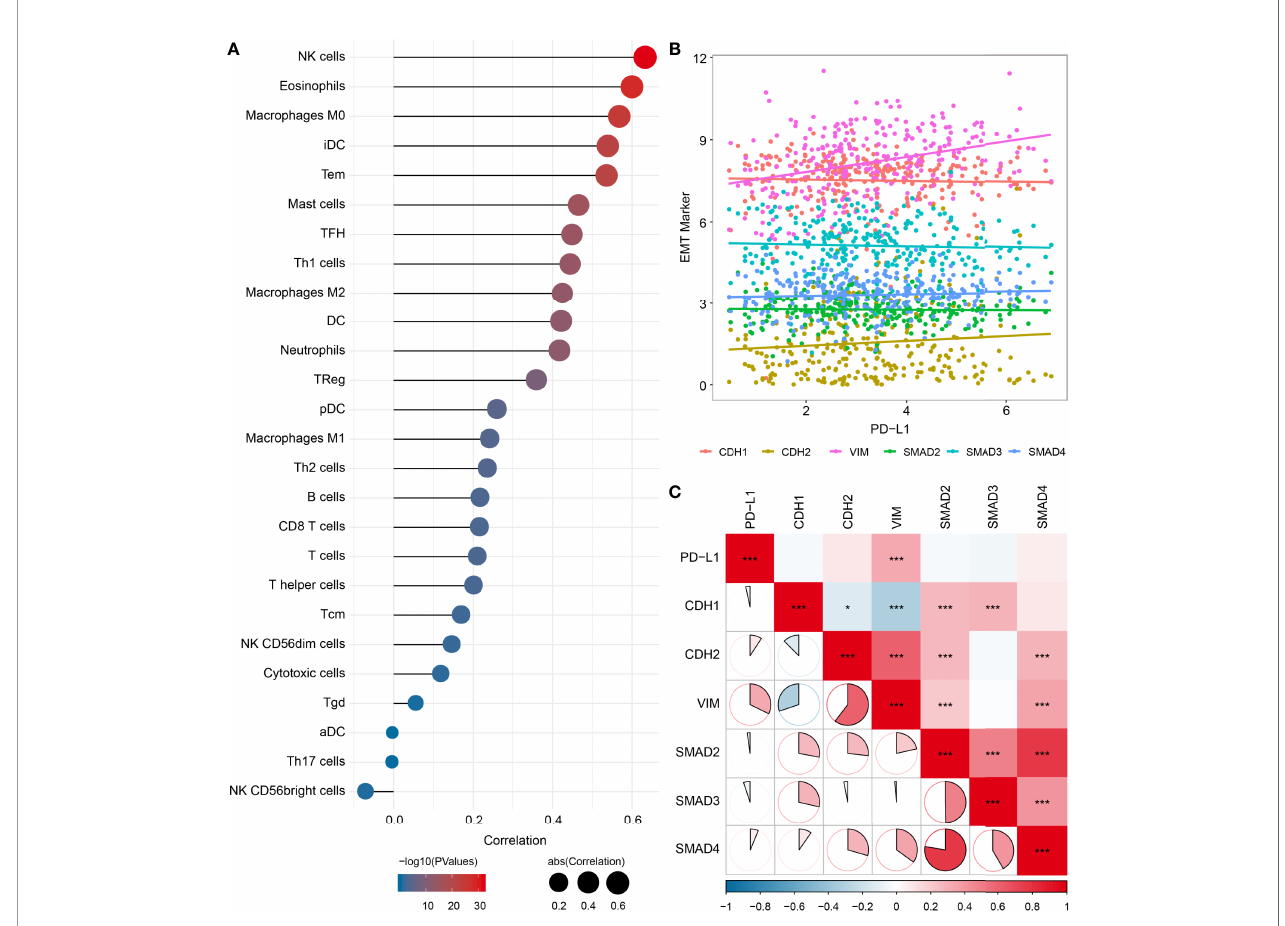
FIGURE 5 | Relationship among PD-L1, immune in fi ltrates and EMT in OSCC samples. (A) Correlation between EMT pathway enrichment scores and immune cell in fi ltration. (B) Scatter plot showing correlation between PD-L1 and EMT-related genes. (C) Correlation between PD-L1and EMT-related genes. *P < 0.05; ***P <